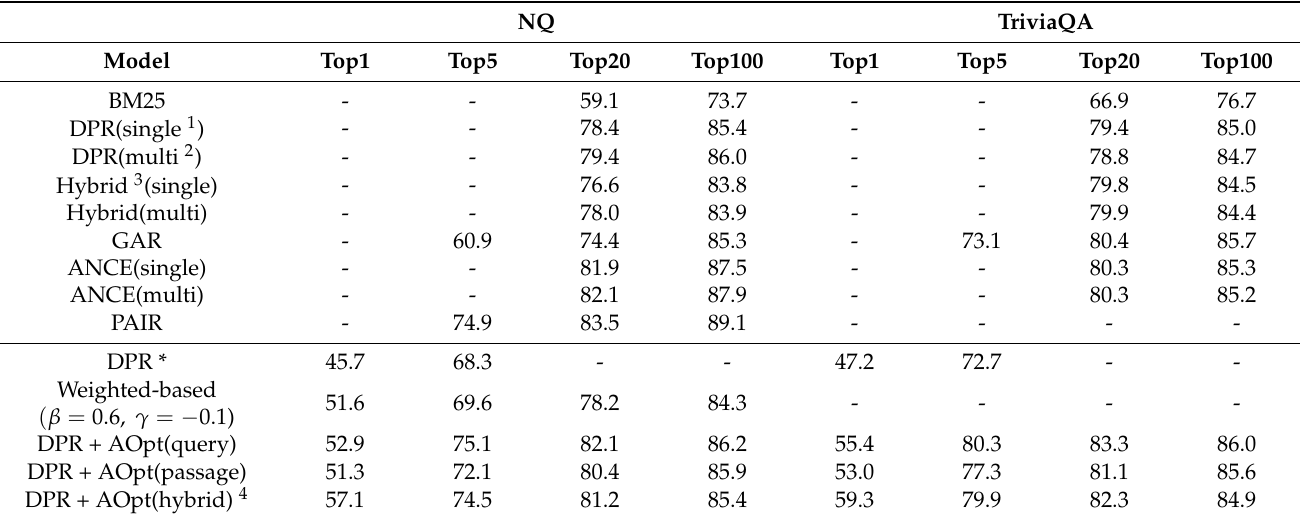
Table 3. Retrieval of Top-k